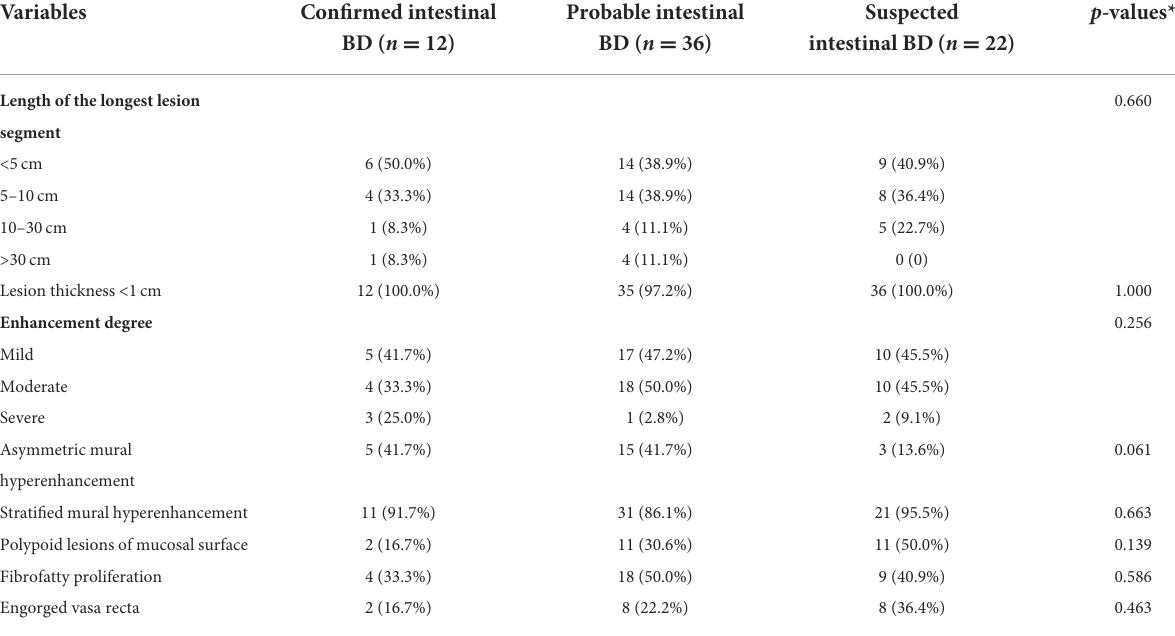
TABLE 1 Comparison of CTE features among subgroups of intestinal BD.